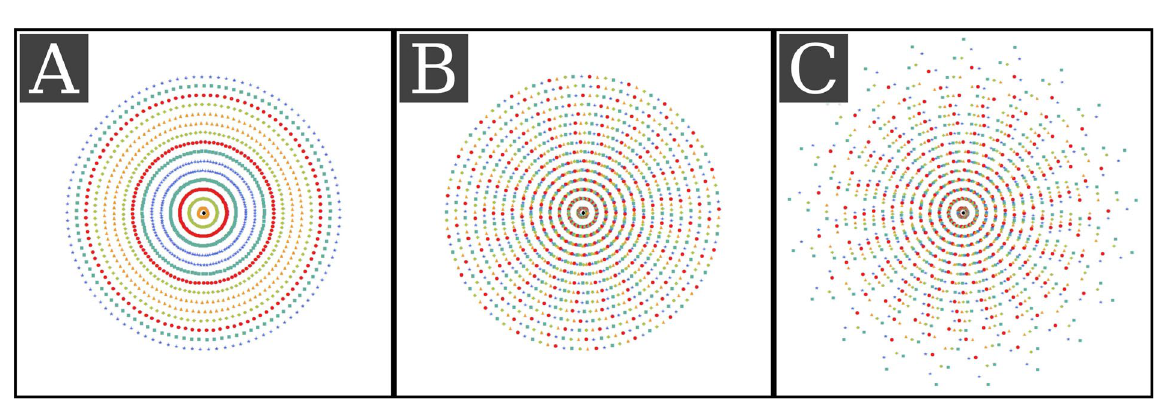
Figure 3. Visualization of the sampling of the proposed expanded Radon space for different acquisition patterns. The location of the symbols represents the location of the measurement in conventional Radon space using spherical coordinates. The color and shape represent the interferometer phase at which the measurement was taken. The visualizations where created for a setup with a 10° fan angle. ( A ) Shows a scan using a single fixed grating position. ( B ) Shows a sliding window phase-stepping scan using five grating positions. ( C ) Shows the pattern for the proposed single-shot electromagnetic phase-stepping (SSEPS) acquisition